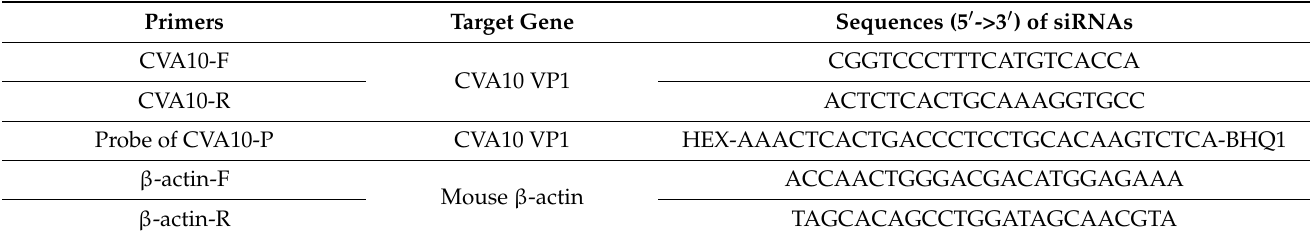
Table 1. List of the sequence of primer pairs specific to target genes. Target